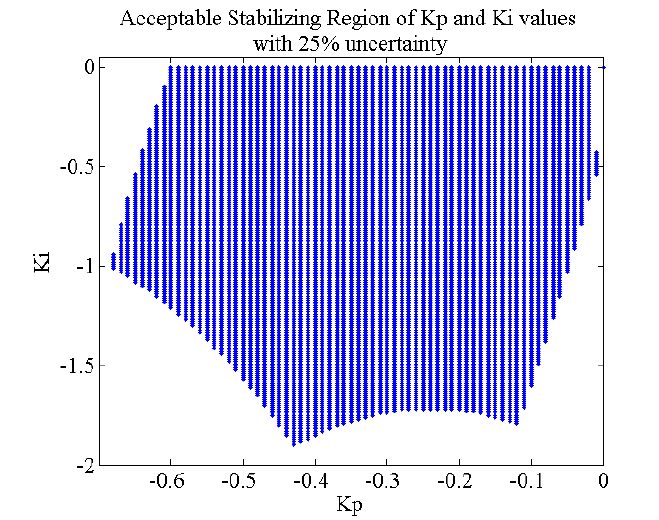
Figure 5. The acceptable stabilizing region when ± 25 % uncertainty is introduced into the wind turbine model